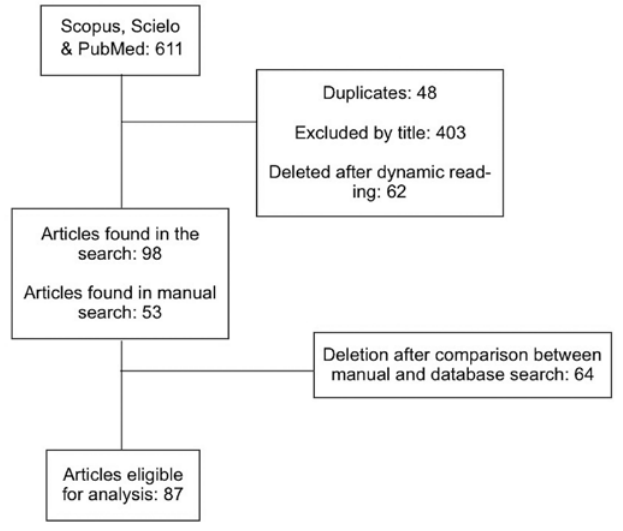
FIGURE 1 - Flowchart of search, exclusion and inclusion of